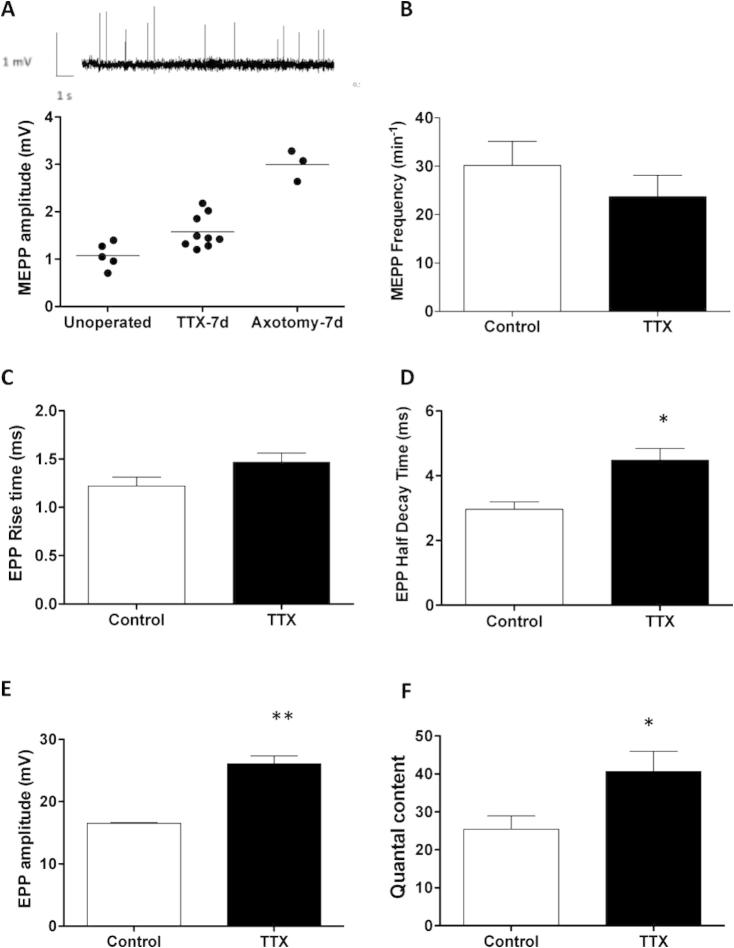
TTX block enhances synaptic transmission. (A) Inset, representative recordings of MEPPs from an FDB muscle fiber of a WldS mouse, after 7 days preconditioning, unilateral sciatic nerve block. MEPP amplitude was significantly increased but, interestingly, not as substantially as in remaining innervated fibers 7 days after axotomy, rather than nerve block (P < 0.01; ANOVA/Bonferroni comparing all three groups). Neither MEPP frequency (B) nor EPP rise time (C) was significantly affected by nerve block. However, EPP half-decay time (D), EPP amplitude (E), and quantal content (F) were all significantly increased (P < 0.05; t-tests in each case). Graphs show mean ± S.E.M., n = 3–9 muscles in each group. Single asterisks, P < 0.05; double asterisks: P < 0.01).